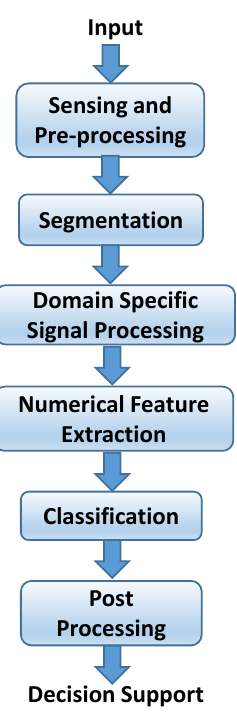
Figure 12. Block diagram representation of signal processing-based fault diagnostic method.